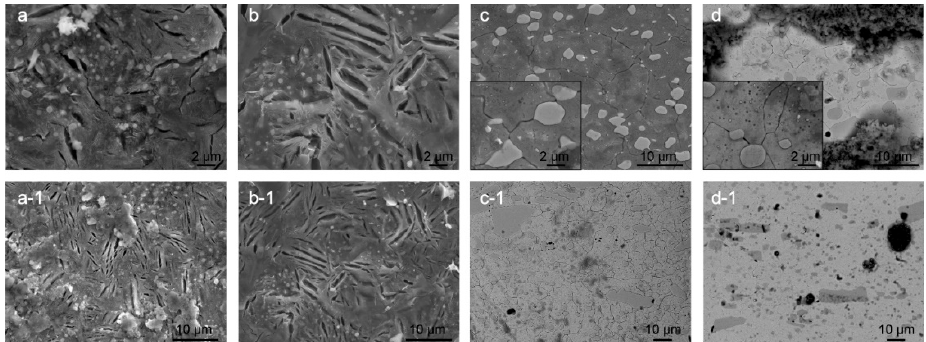
Figure 4. Scanning electron microscopy images of conventional heat-treated ( a ) and deep cryogenic heat-treated ( b ) steel X and conventional heat-treated ( c ) and deep cryogenic heat-treated ( d ) steel Y. The images display dependency of the surface cracking, considered to be related to residual stresses, to the microstructure and heat-treated state. The immersion time for steel X samples was 3 h, whereas for steel Y, the immersion time was 1 day. for steel Y, the immersion time was 1 day.